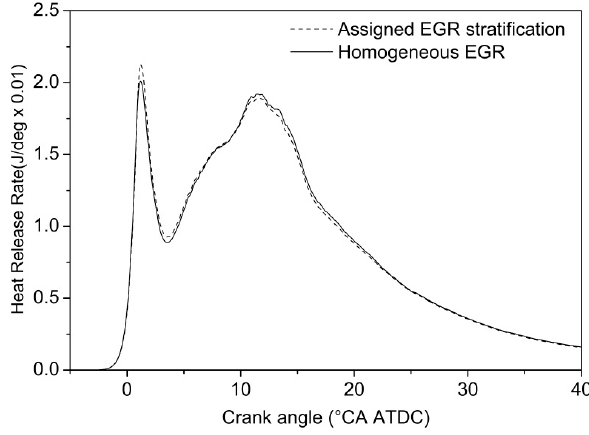
Figure 7. Comparison of heat release rate between uniform EGR and assigned EGR stratification with equal mass of EGR in cylinder.